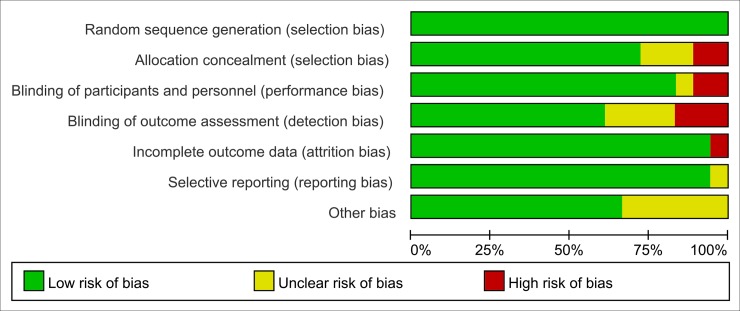
Risk of bias graph: Review authors' judgements about each risk of bias item presented as percentages across all included studies.